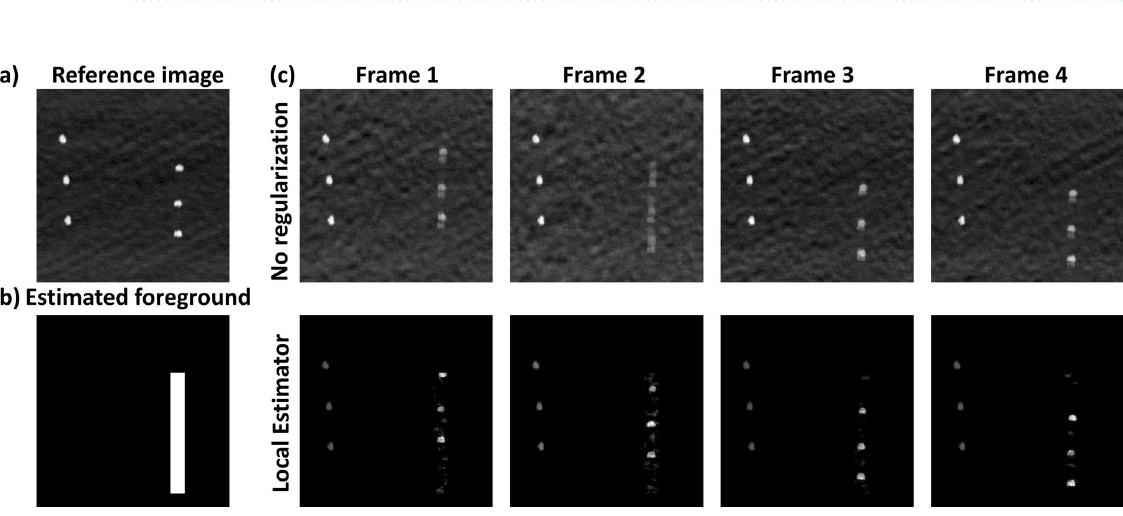
Table 5. Summary of results global estimator experiment.